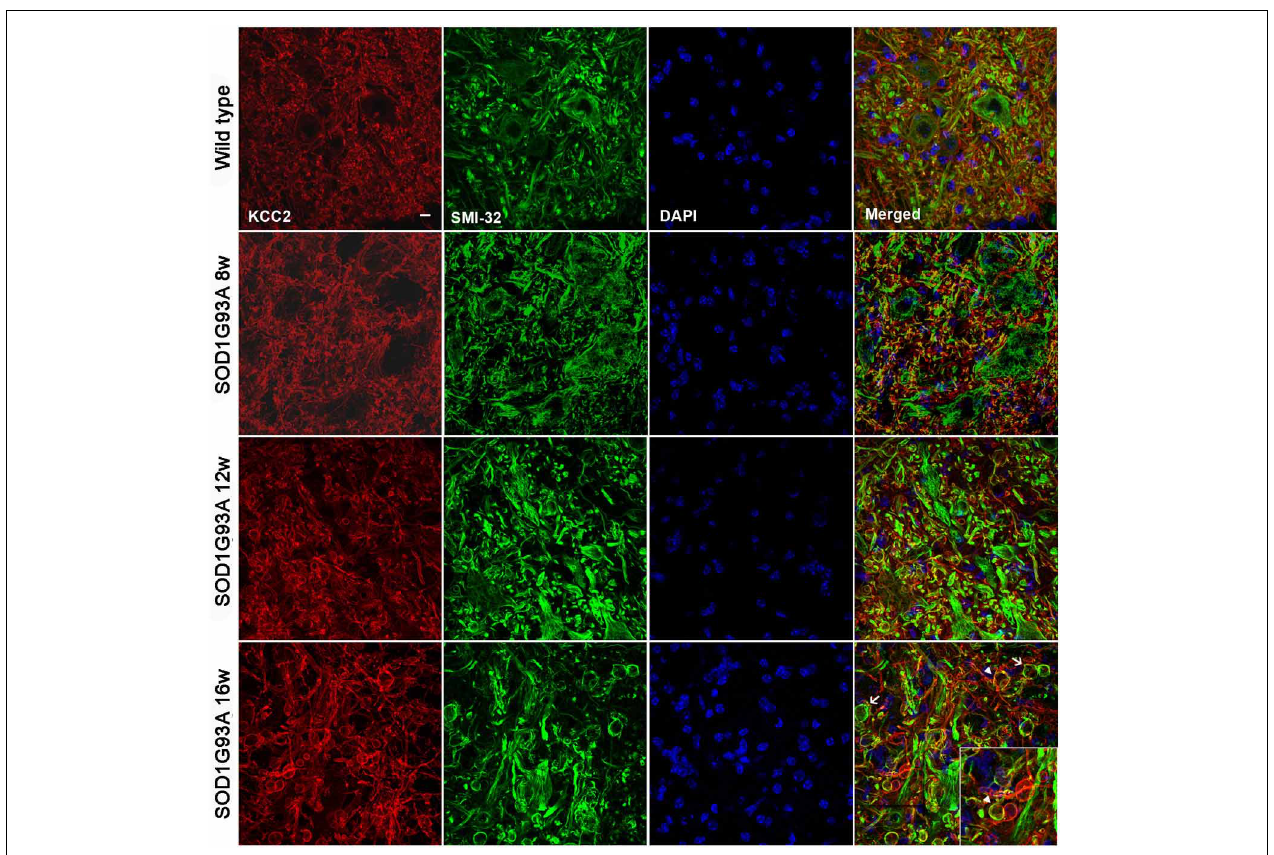
structures (arrow) along the disease progression in SOD1 G93A animals. The KCC2 remained localized in the cell membrane even in these swallows (arrowheads). Scale bar 10 µ